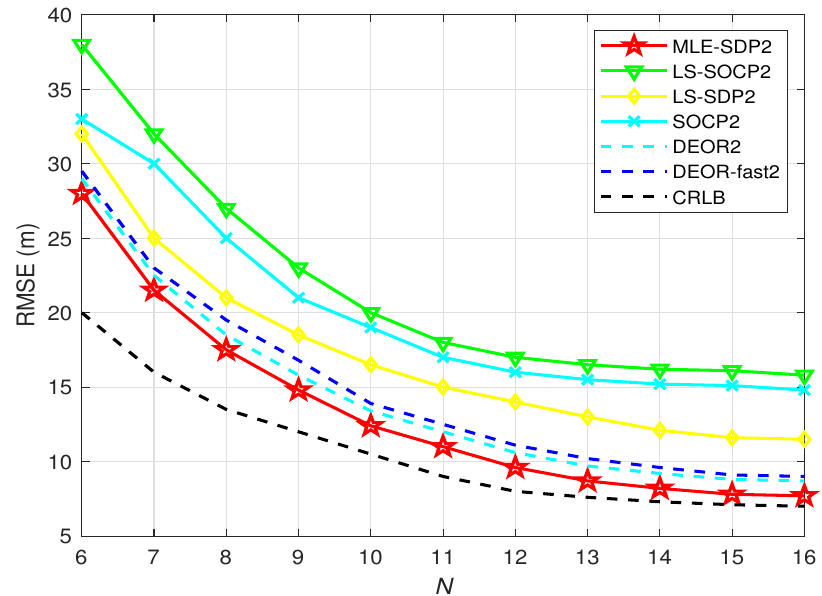
Figure 6. When L 0 is unknown, the relationship between RMSE versus N